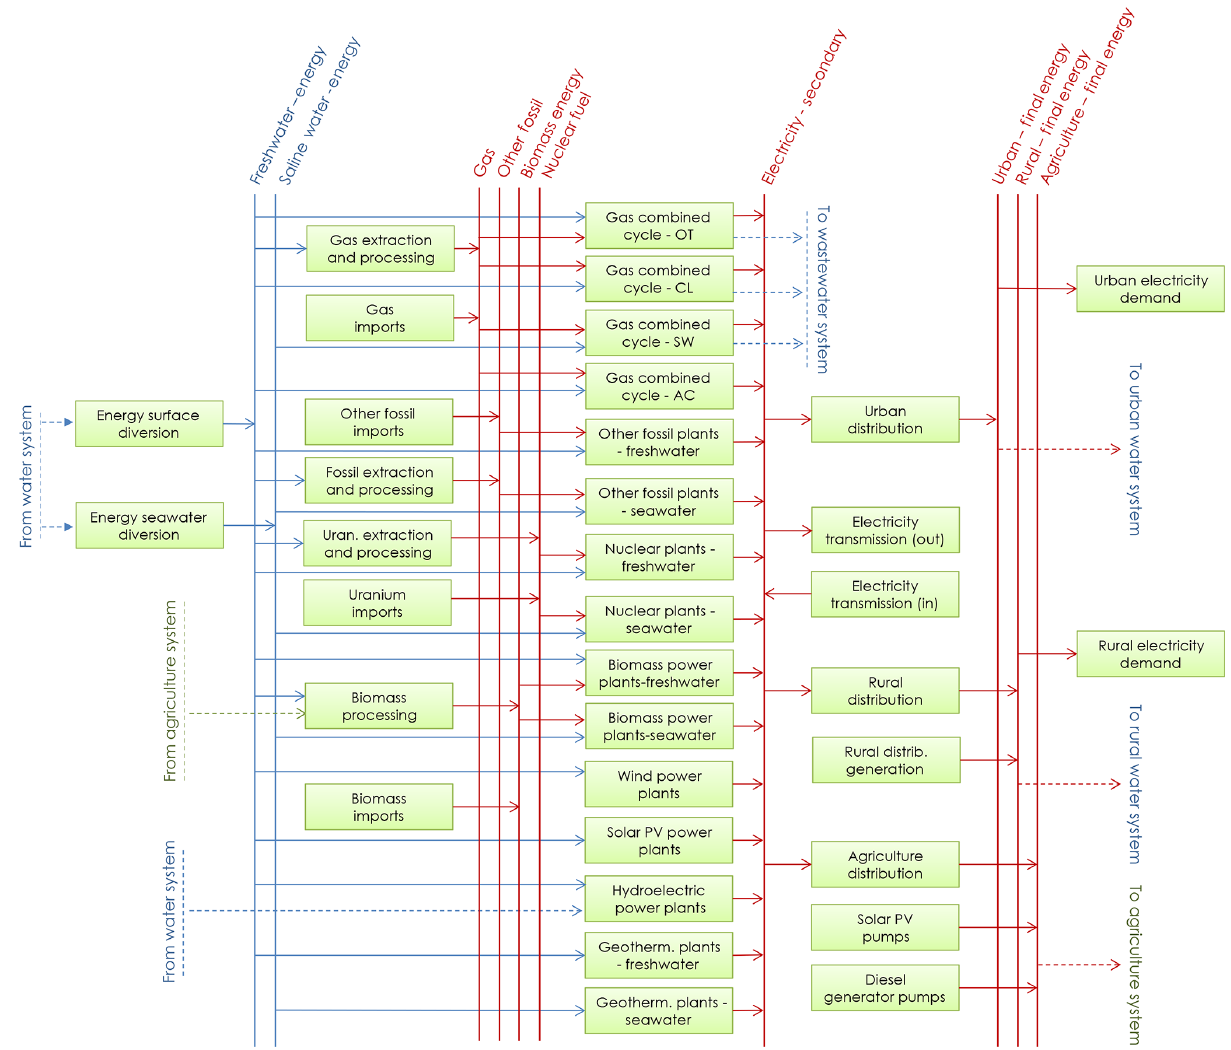
Figure 4. The energy sector representation in each BCU using the MESSAGEix reference system scheme. The energy sector is hard linked to the water and agriculture sector representations using the indicated